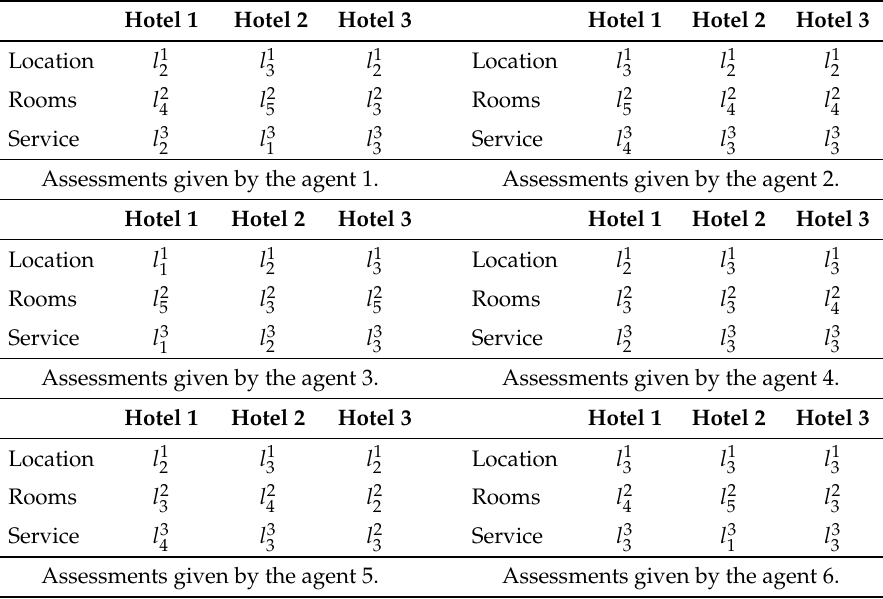
Table 3. Linguistic assessments given by the